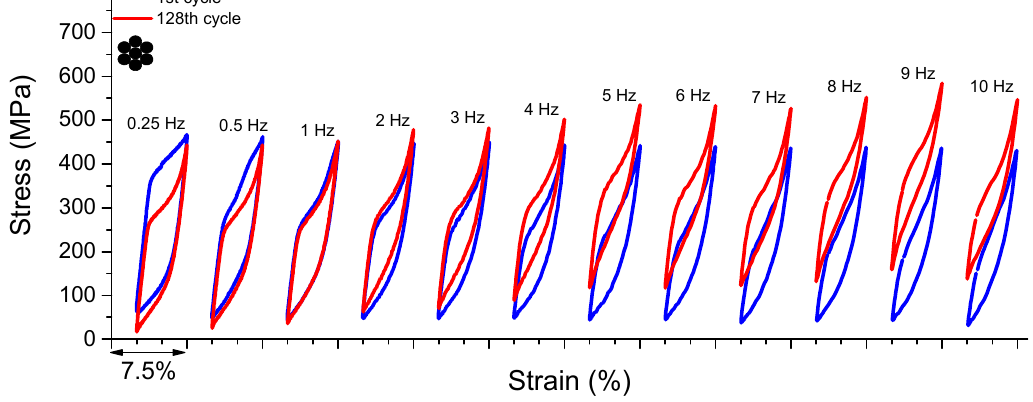
Figure 6. Dynamic response of the superelastic behavior of the NiTi SMA micro cable for loading frequencies from 0.25 Hz to 10 Hz.